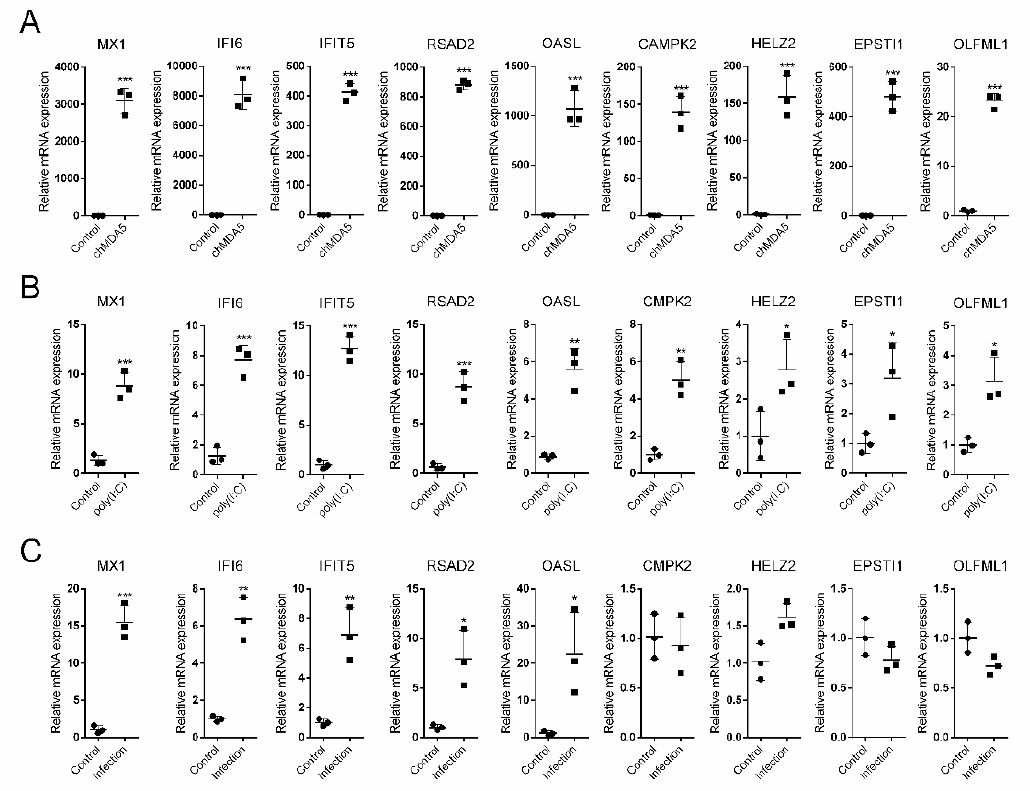
Figure 5. Verification of the upregulated DEGs by qRT-PCR. The total RNA of ChMDA5, poly(I:C) transfected DF1 cells ( A , B ), or H5N6 virus infected DF1 cells ( C ) were extracted, and the selected gene expression levels were determined by qRT-PCR. Expression of all the selected genes was normalized to GAPDH. The values are shown as the mean and SD and are representative of three independent experiments. Data were analyzed using Student’s t test. ***, p < 0.001; **, p < 0.01; *, p < 0.05.